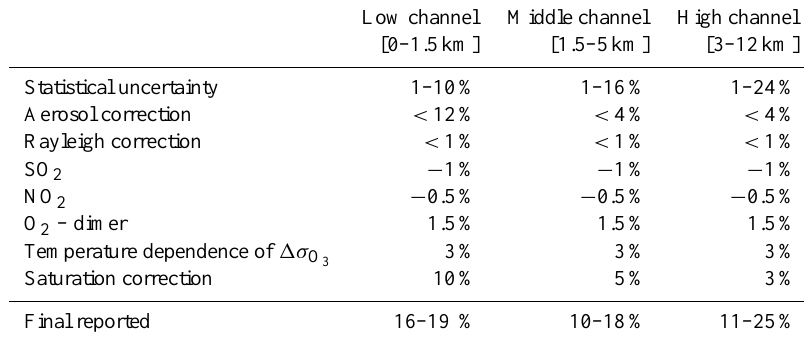
Table 2. A list of the quantified uncertainties associated with the GSFC TROPOZ DIAL instrument during the test case on 25 October